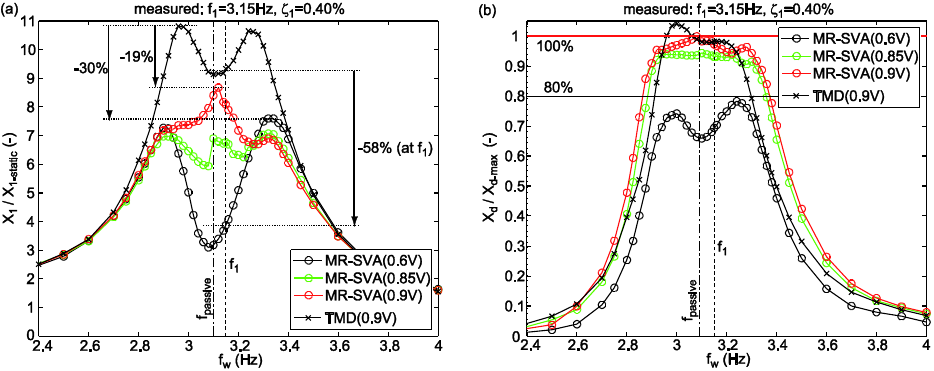
Figure 12. Measured ( a ) vibration reduction and ( b ) relative motion amplitude for nominal bridge. Actuators 2016 , 5 , 27